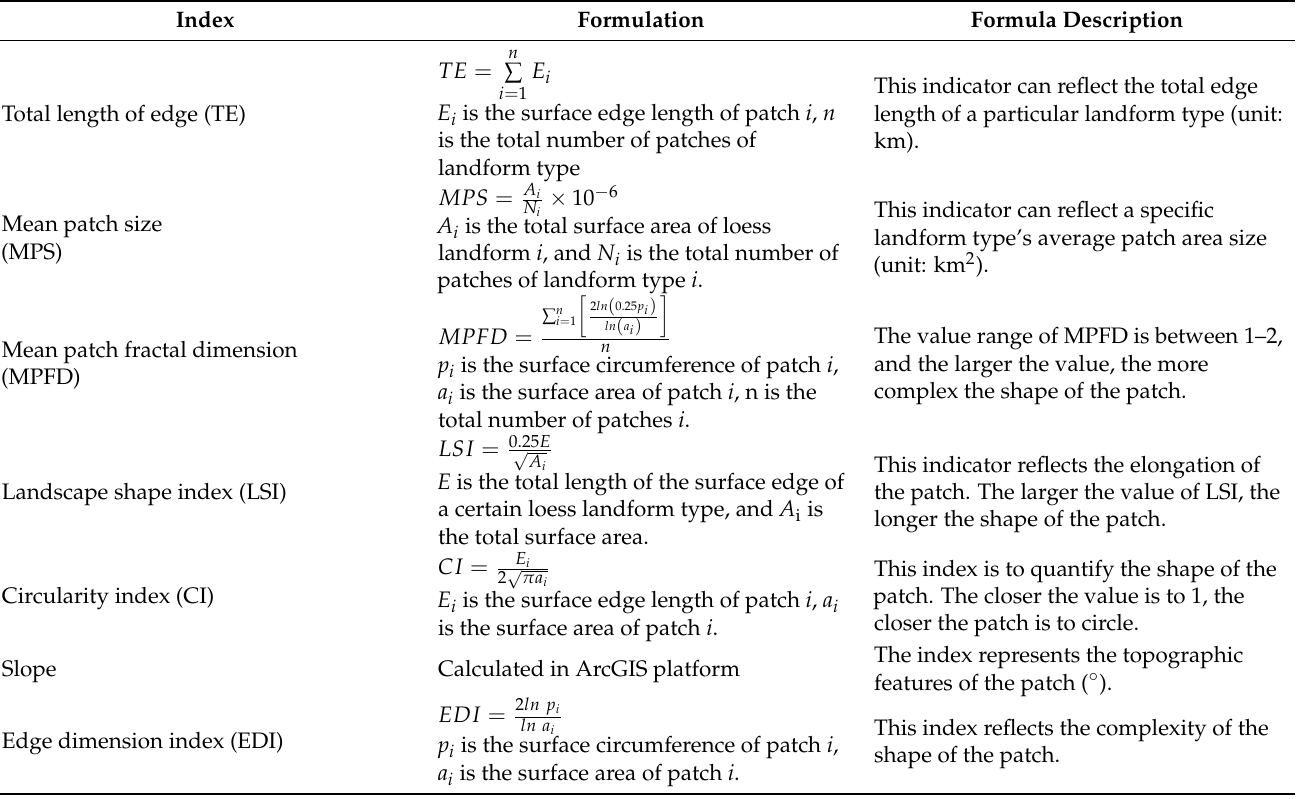
Figure 4. Sketch of the calculation method to determine the surface area of patches. According to the research requirements, different representative indices are selected from the morphological and landscape levels to analyze the difference of loess landform types. The selected indices are shown in Table 2. Table 2. Selected landscape indices and their description.